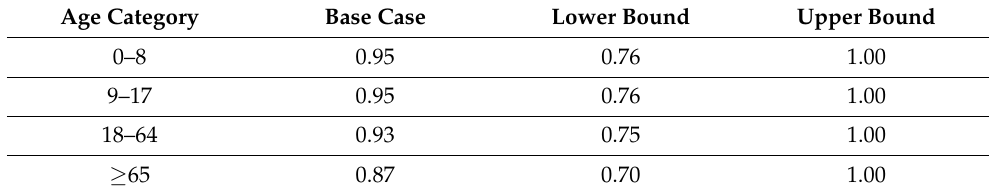
Table A8. Lower and upper bounds for reference utilities (healthy